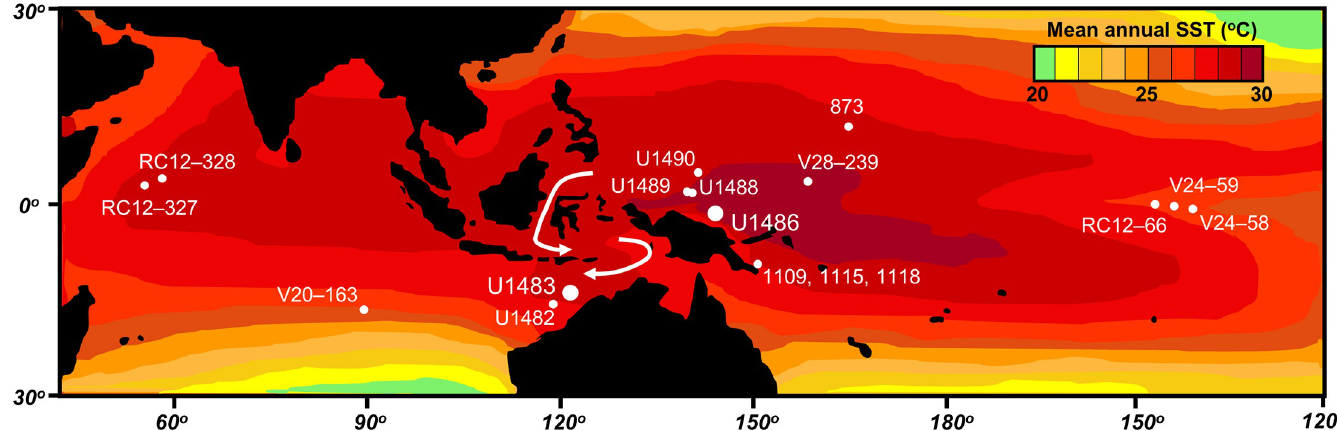
Fig 4. Locations of Pulleniatina coiling records discussed in this study. Larger circles denote the two sites from which new data are presented. Arrows indicate path of the main Indonesian through-flow from the Pacific to Indian Oceans. SST = sea surface temperature. Mean annual temperature data: NASA, redrawn.